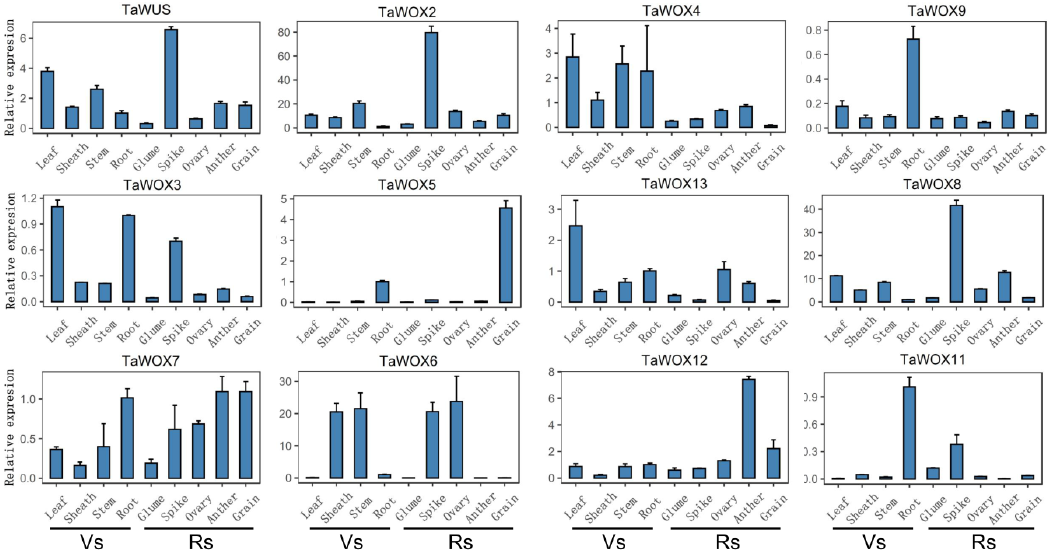
Figure 3. Expression profiles of 12 TaWOX genes in different tissues or organs. Quantitative real time polymerase chain reaction (RT-qPCR) was used to detect the expression levels of the TaWOX genes. The tissues or organs evaluated were the leaf, leaf sheath, stem, root, glume, spike (young spike), ovary, anther, and grain from left to right. Vs, vegetative stage. Rs, reproductive stage. TaActin was used as an internal control. Each value represents the mean of three biological replicates ± SE.